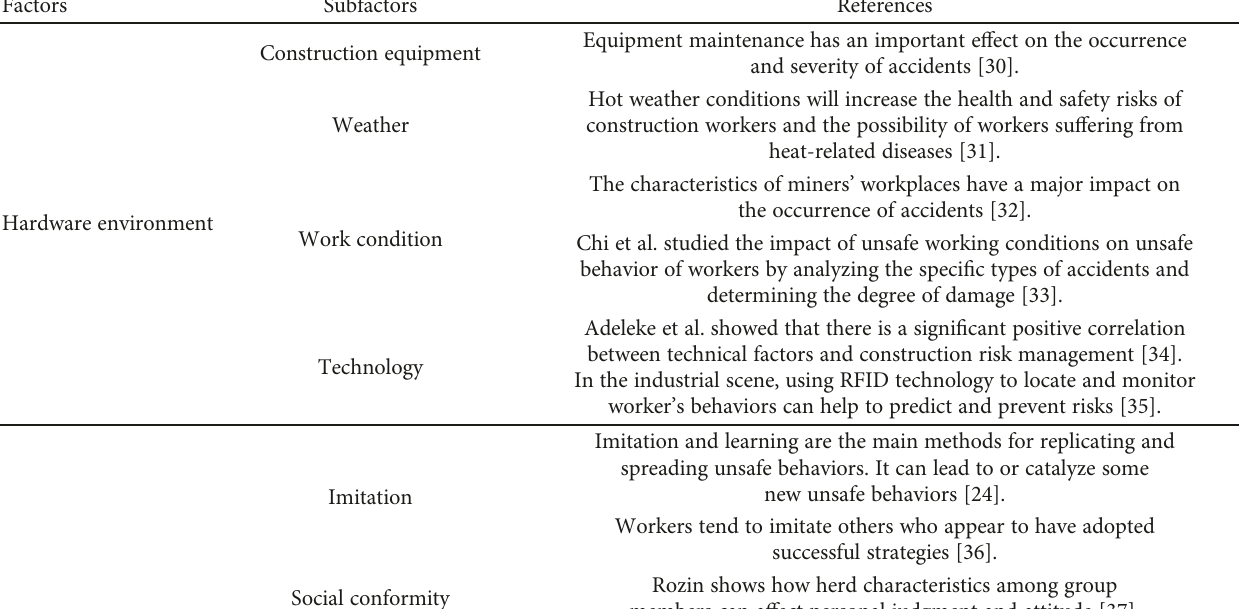
Table 2: Summary of subject interactions and environment on unsafe behavior in construction teams.